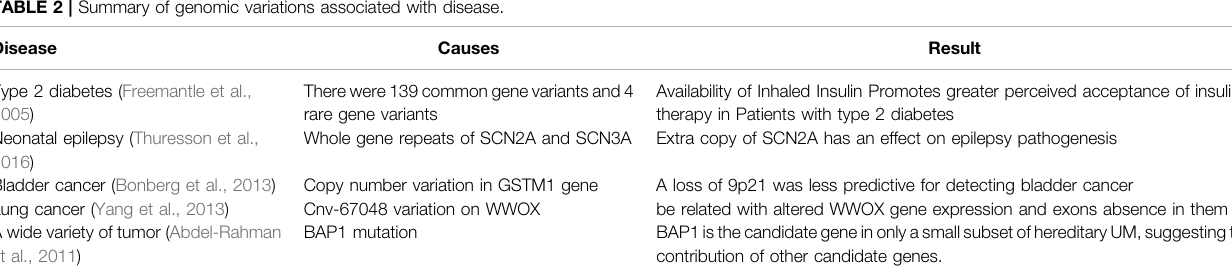
TABLE 2 | Summary of genomic variations associated with disease. Disease